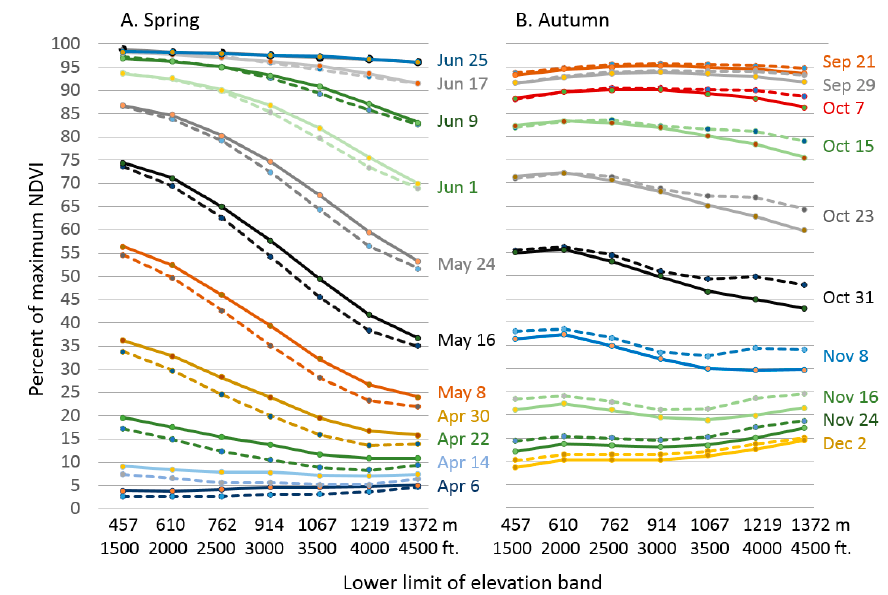
Figure 3. The influence of elevation and aspect on spring and autumn land surface phenology for deciduous forests of Great Smoky Mountains National Park, 2000–2015. For each similarly colored and dated pair, the mean for mesic cells is shown by a solid line while xeric cells are represented by dashed lines.